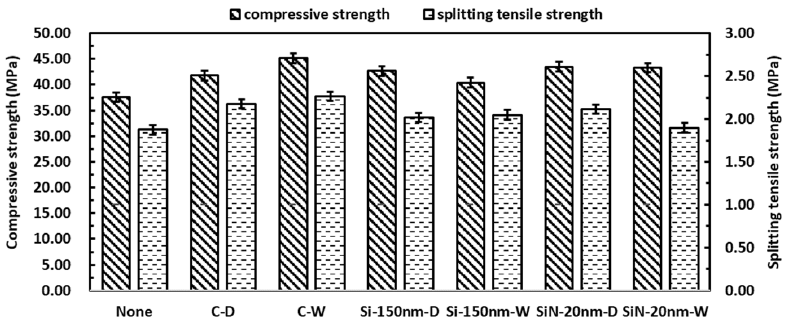
Figure 8. The mechanical property of the concrete made by different modified materials. From Figure 8, the compressive strength of the concrete with different modified recycled coarse aggregate is plot on left axis and the splitting tensile strength is plot on the right one. Compared to the None group, the compressive strength and splitting tensile strength of all other groups are all increased. This phenomenon proves that the modified recycled coarse aggregate can enhance the mechanical property of the